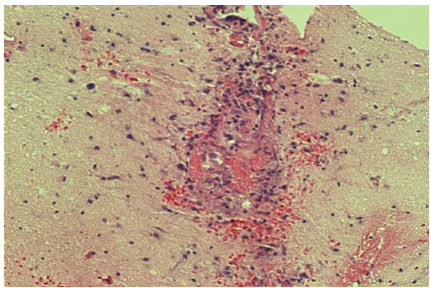
Figure 4: Clear features of vasculitis: a small sized vessel with endothelial cell edema, infiltration by lymphocytes, neutrophils and possibly macrophages, necrosis, and hemorrhage. There is also brain parenchyma necrosis around the affected